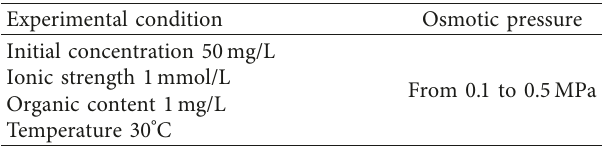
Figure 2: Schematic diagram of GCLs permeameter. Table 4: The parameters of